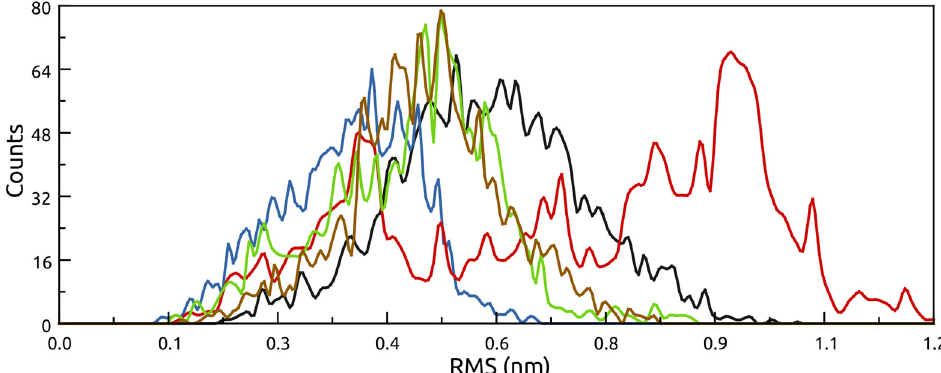
Figure 5. RMS matrix histogram showing the abundance of the conformer ensembles at 400 K. P-As (black), T-Pf (blue), M-Sm (red), P-Mm (green), M-Sp (brown). (black), T-Pf (blue), M-Sm (red), P-Mm (green), M-Sp